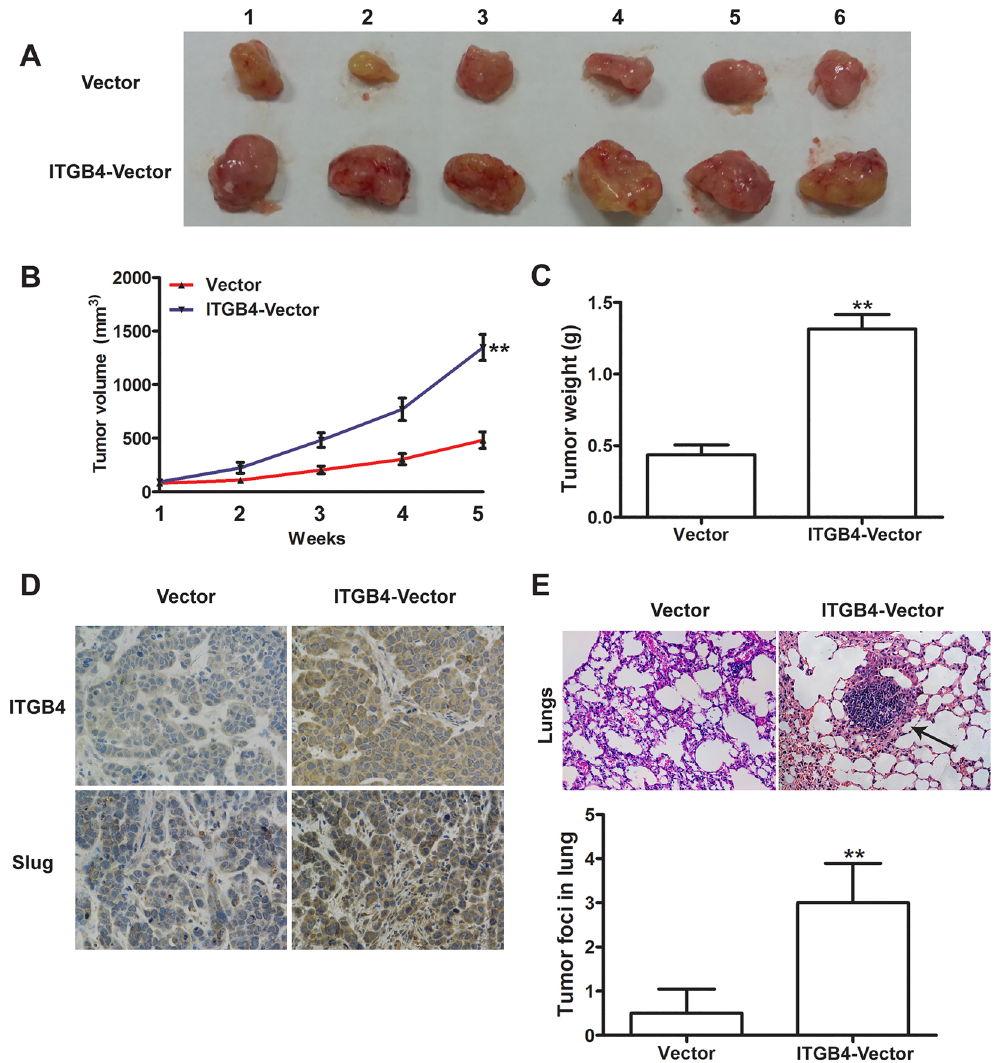
Figure 5. Effects of ITGB4 overexpression on HCC growth and metastasis in vivo. ( A ) Representative images of the xenograft tumors formed in nude mice (n = 6 per group) injected with empty vector or ITGB4-transduced cells. ( B , C ) Growth curve and weight of xenograft tumors, exhibiting both significantly greater volume and weight of tumors derived from nude mice injected with ITGB4-transduced cells compared with control after 5 weeks. **P < 0.01. ( D ) Immunohistochemical staining for ITGB4 and Slug in tumor tissues from mice with subcutaneous HCC implantation, demonstrating significantly ITGB4-overexpression and Slug-overexpression in tumor tissues derived from nude mice injected with ITGB4-transduced cells compared with control (original magnification: 400×). ( E ) Representative H&E staining of lung metastatic foci from mice injected with vector control or ITGB4-transduced cells, exhibited an approximately 3-fold higher incidence of metastatic foci in mice injected with ITGB4-transduced cells than in those bearing vector control tumors. **P <